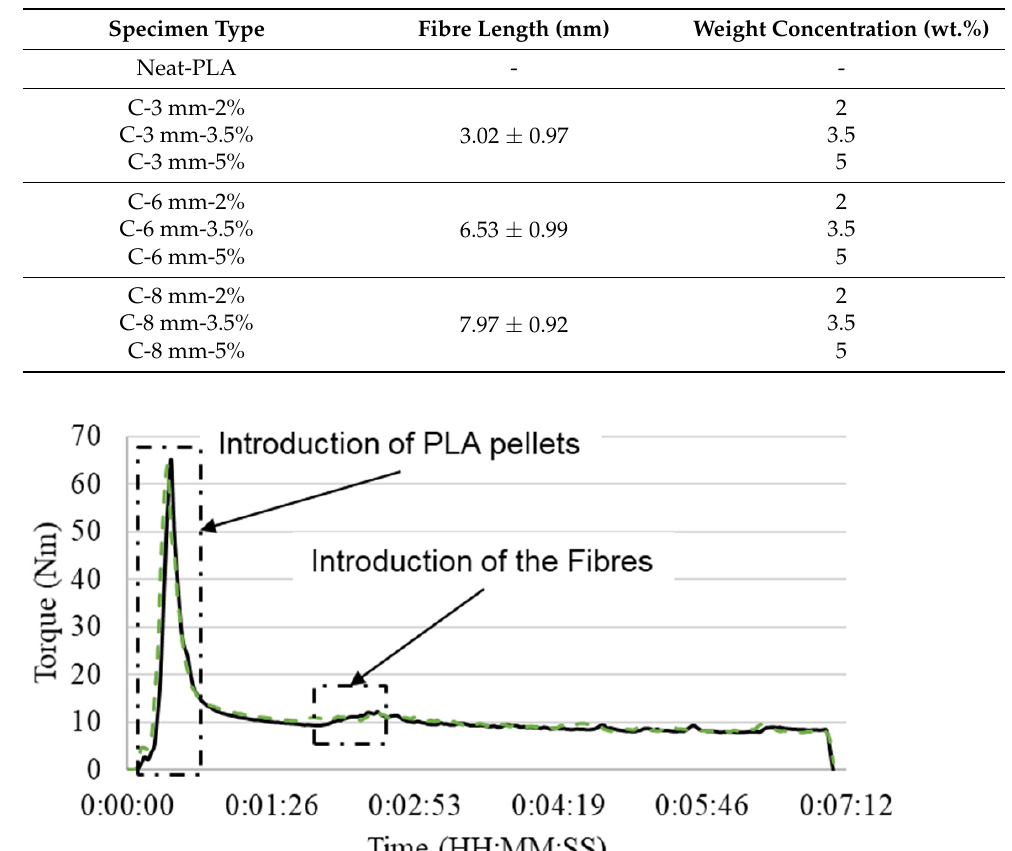
Table 2. Nomenclature of the specimens as a function of reinforcement (average fiber length and wt.%).